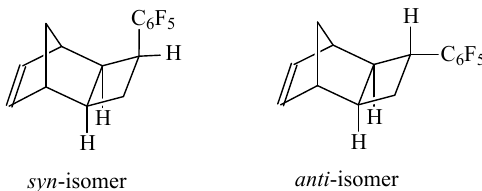
Figure 2. The structures of two isomers of 3-pentafluorophenyltricyclononene-7.